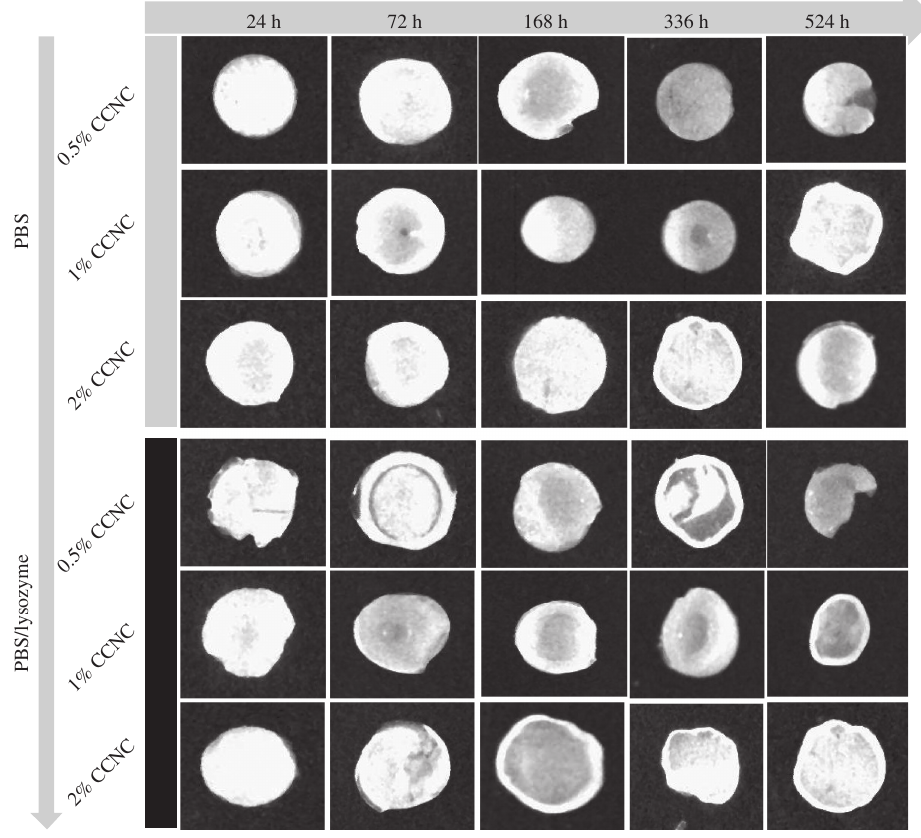
Figure 7: Representative photoacoustic imaging of in vitro degradation of DEX/CCNC/MPDA-TPE hydrogels with different content of CCNC in the absence of lysozyme or in the presence of lysozyme over